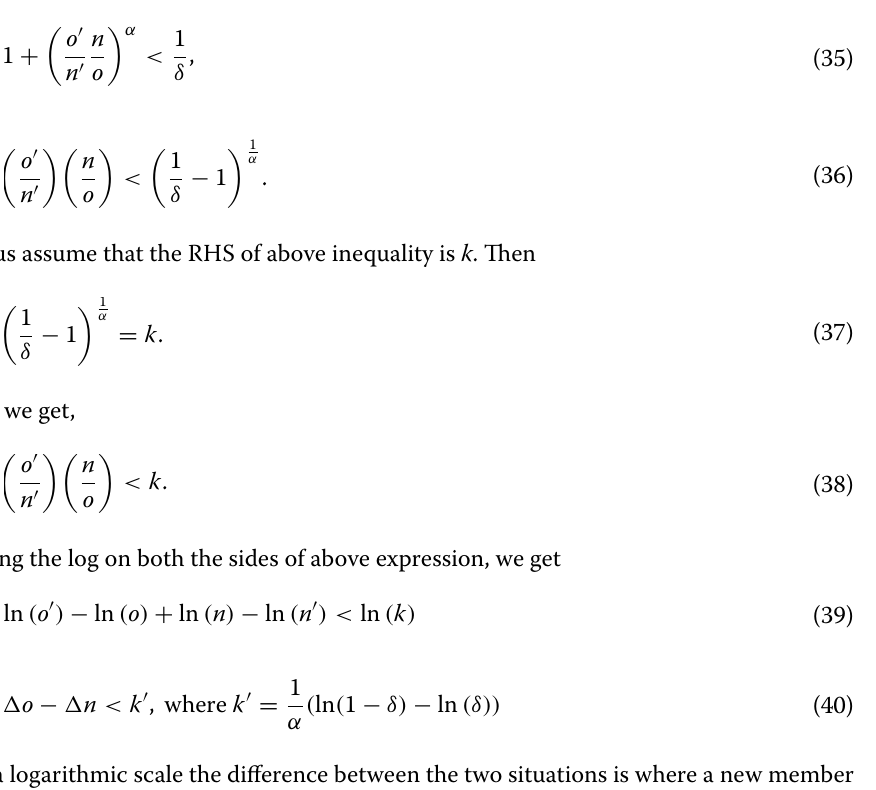
Table 5 Statistics of unweighted real networks are given below (Csardi 2015; Csardi and Nepusz 2006)